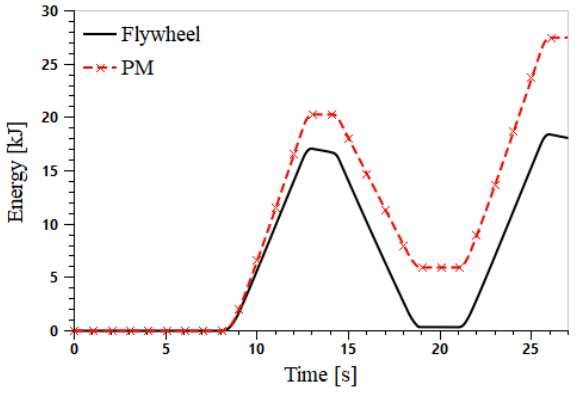
Figure 15. Energy curves of the flywheel and PM of the proposed system when the excavator bucket is empty. Table 2. Summarization of energy-saving effect.